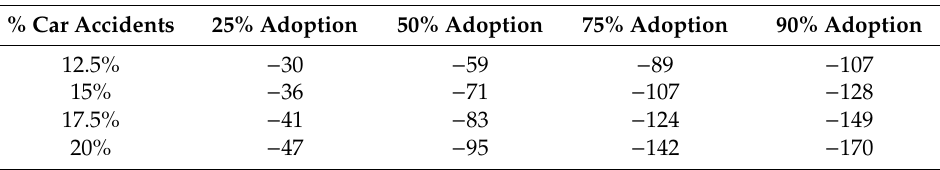
DIMINUTION in PANCREAS (Based on WHO data for 2015 in United